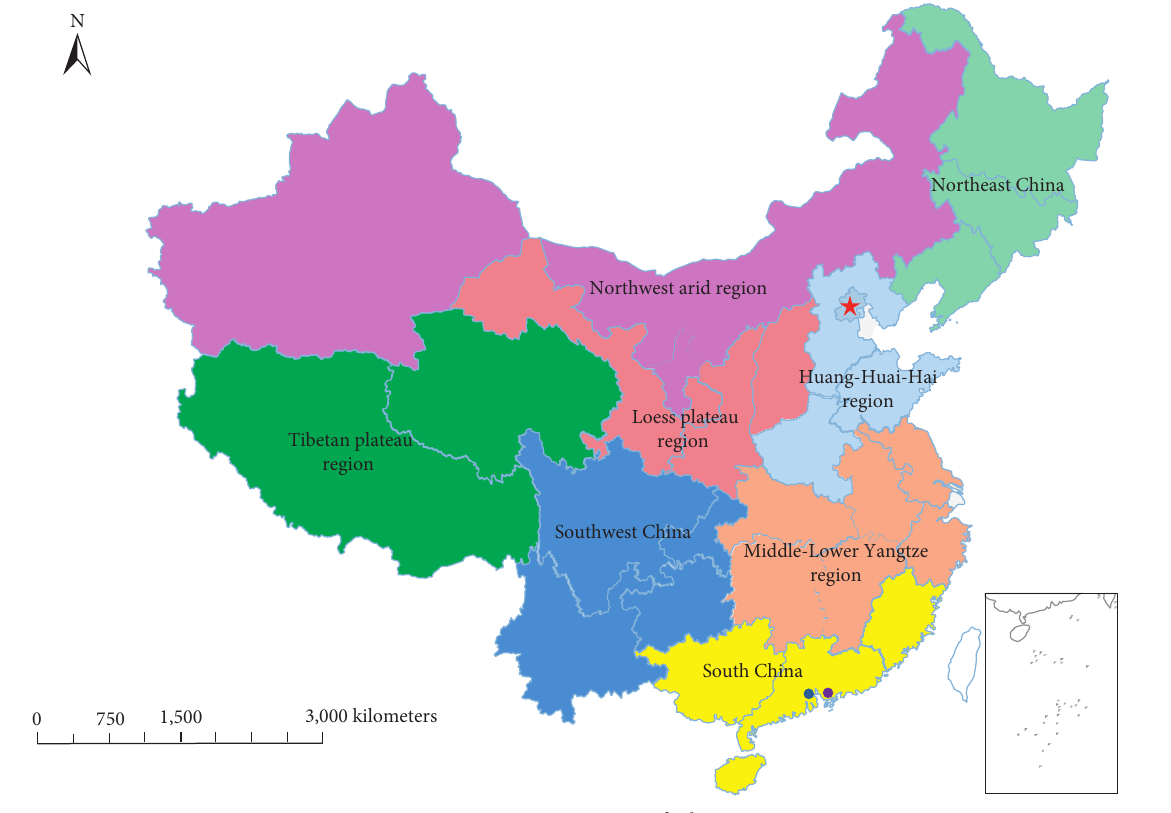
Figure 1: Major regions of China. Table 6: Enquiry table for the urea application quantity of early rice straw returning to the field with different yields per unit